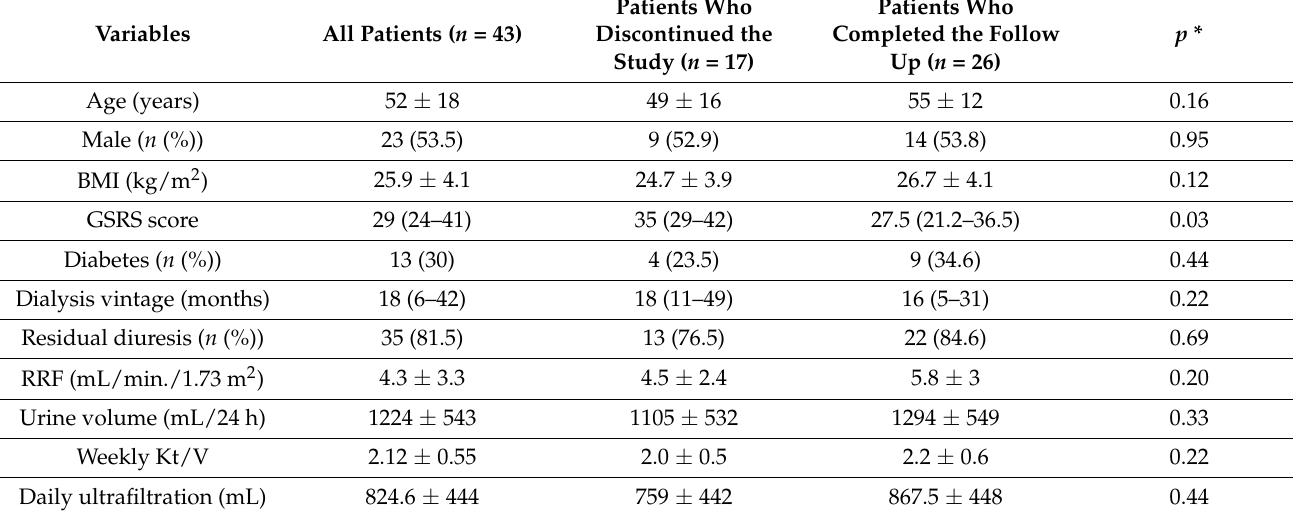
Figure 2. Consolidated Standards of Reporting Trials (CONSORT) flow diagram. UBF—unripe banana flour. Table 1. Baseline characteristics of all randomized patients, patients who discontinued the study, and patients who completed the follow